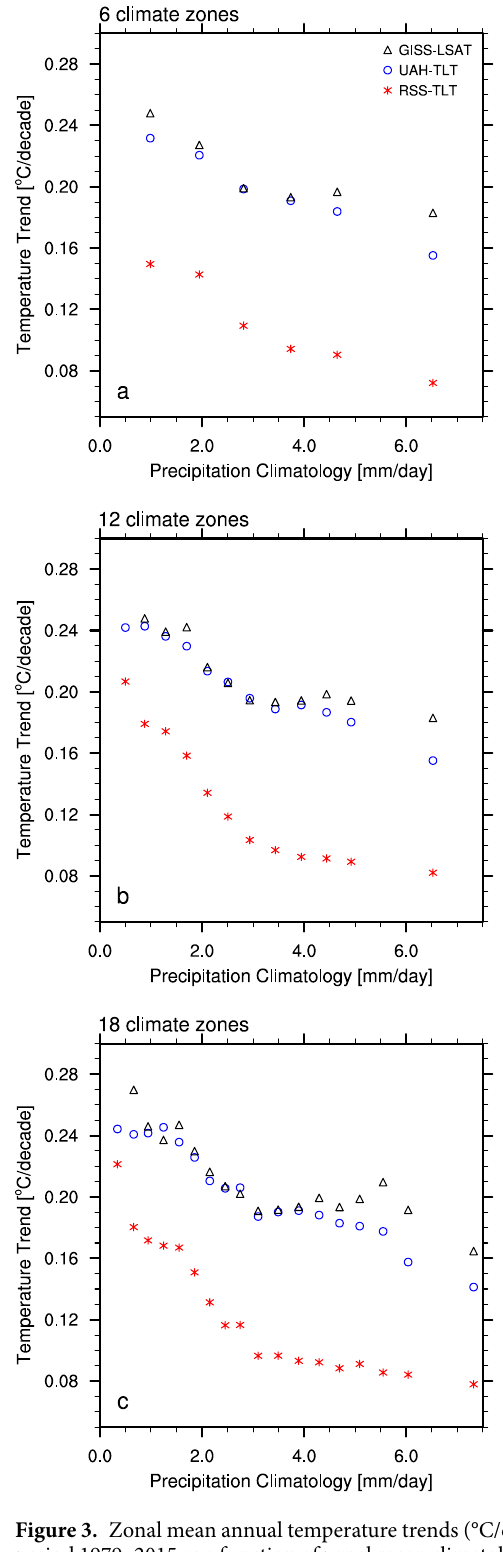
Figure 3. Zonal mean annual temperature trends (°C/decade) of RSS-TLT, UAH-TLT and GISS-LSAT for the period 1979–2015 as a function of zonal mean climatological annual precipitation (mm/day) in terms of ( a ) 6, ( b ) 12 and ( c ) 18 large-scale climate